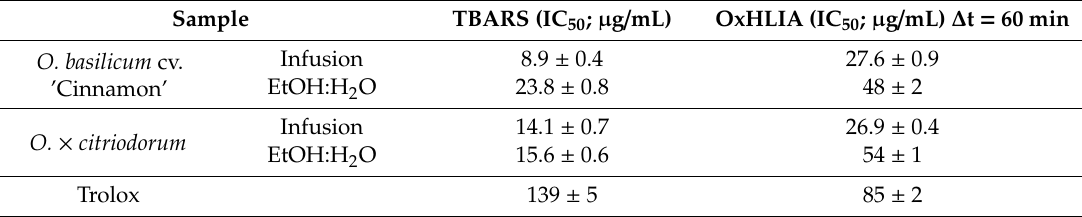
Table 3. Results of the antioxidant activity assays (TBARS and OxHLIA) obtained for the infusion and hydroethanolic extracts of basil samples (mean ± SD, n =